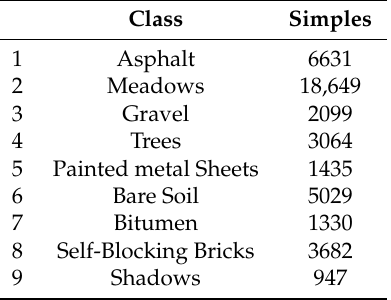
Figure 5. The schematic diagram of ROSIS image. Table 3. The ground category and sample number of ROSIS.